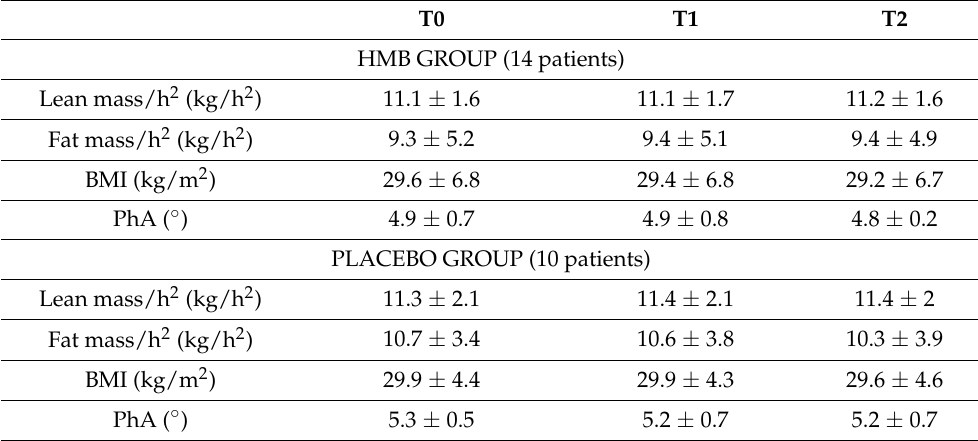
Table 2. Changes in body composition according to BIA across the study.